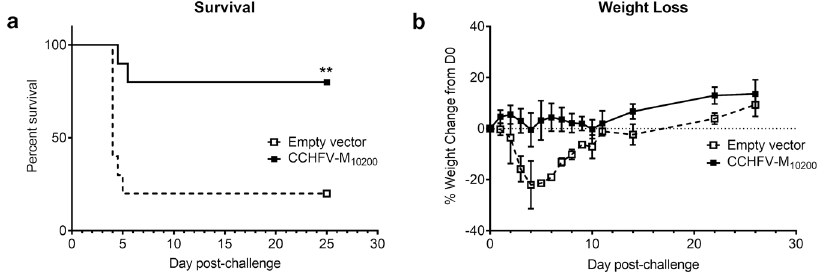
Fig. 6 CCHFV-M 10200 DNA vaccination provides signi fi cant protection against heterologous challenge. Groups of 10 female C57BL/6 mice were vaccinated with 50 μ g CCHFV-M 10200 or empty vector on days 0, 21, and 42 by IM-EP. a Group survival and ( b ) weight change following CCHFV challenge with 100 PFU by the IP route with the heterologous CCHFV-Afg09-2990 strain. Vaccinated C57BL/6 mice were transiently immunosuppressed prior to challenge. ** p < 0.01. The percent survival p value was determined by a log rank test.